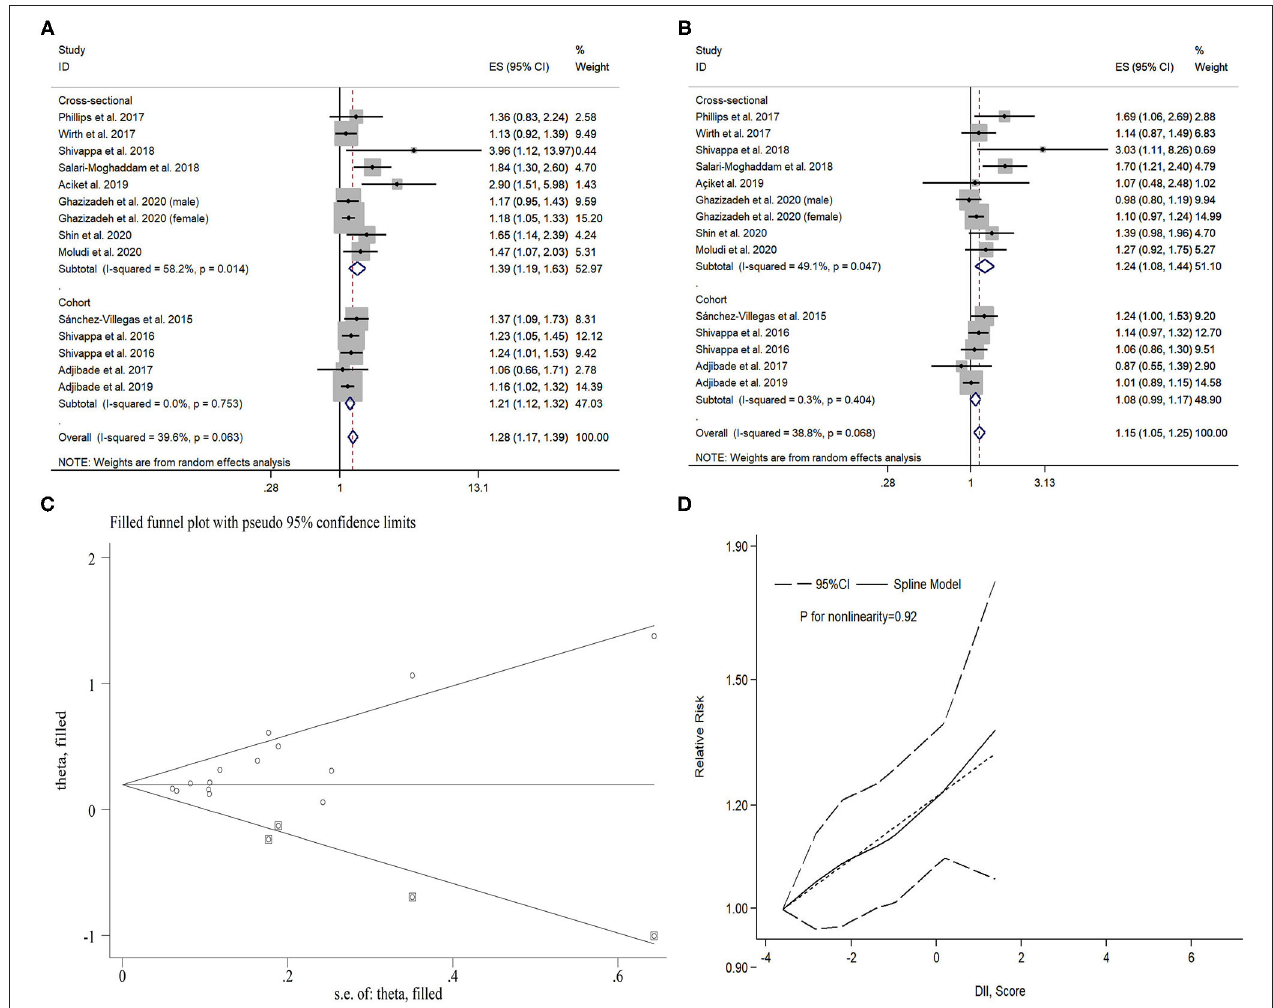
FIGURE 2 | Forest plot of the pooled effect estimates of symptoms of depression. (A) The highest Dietary Inflammatory Index (DII) category compared with the lowest category. (B) The second highest DII category compared with the lowest category. (C) Filled funnel plot with 95% CI using the trim-and-fill method. (D) Dose–response relationship between DII and symptoms of